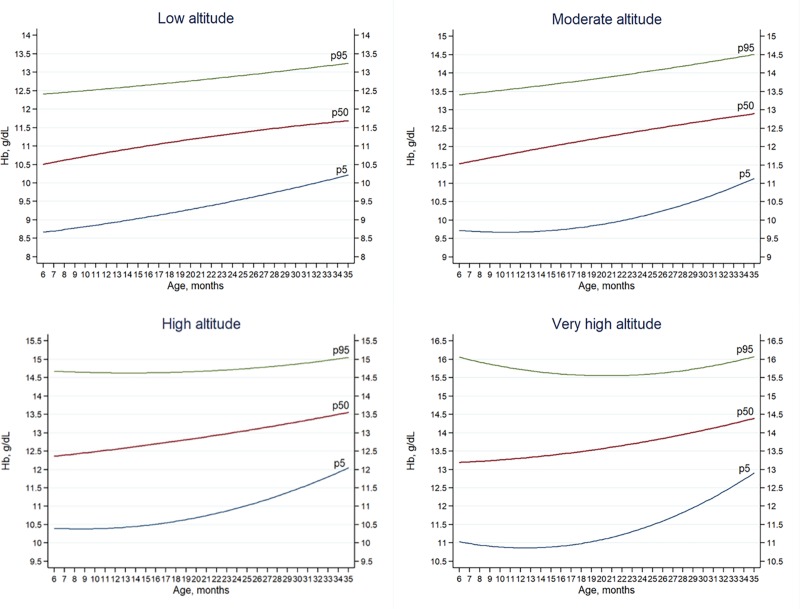
Hemoglobin percentiles by age and altitude categories (masl).In order, from bottom to top: p5 (blue), p50 (red), p95 (green). Percentile curves as estimated using altitude of residence show that Hb increases along with age. However, some differences arise: At lower altitudes, the p5 curve follows the equation 8.47+ 2.87*10−2*x+ 6.04*10−4*x2 and p50 follows the equation 10.16+ 6.12*10−2*x- 5.02*10−4*x2. At moderate altitudes the p5 curve follows the equation 9.94–5.17*10−2*x+ 2.45*10−3*x2 with the lowest estimated value found at 10.6 months, and the p50 curve follows the equation 11.20+ 5.81*10−2*x- 2.72*10−5*x2 which shows an upward trend across the age range. At high altitudes the p5 curve follows the equation 10.55–4.08*10−2*x+ 2.38*10−3*x2 with the lowest estimated value found at 8.6 months. The p50 equation is 12.20+ 2.42*10−2*x+ 4.11*10−4*x2, which follows an upward curve for the age range. At very high altitudes p5 follows 11.49–10.09*10−2*x+ 4*10−3*x2 with the lowest estimated value found at 12.5 months. The p50 follows 13.15+ 1.31*10−3*x+ 9.78*10−4*x2 which has an upward trend for the given age range.